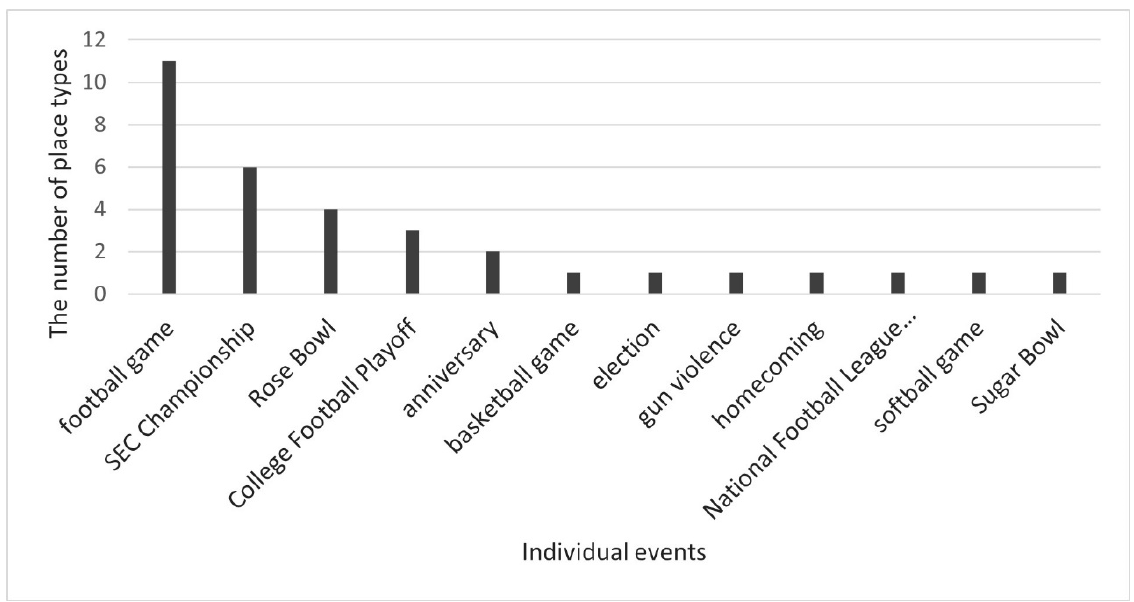
Figure 6. Multiplicity of place types vs. event types.